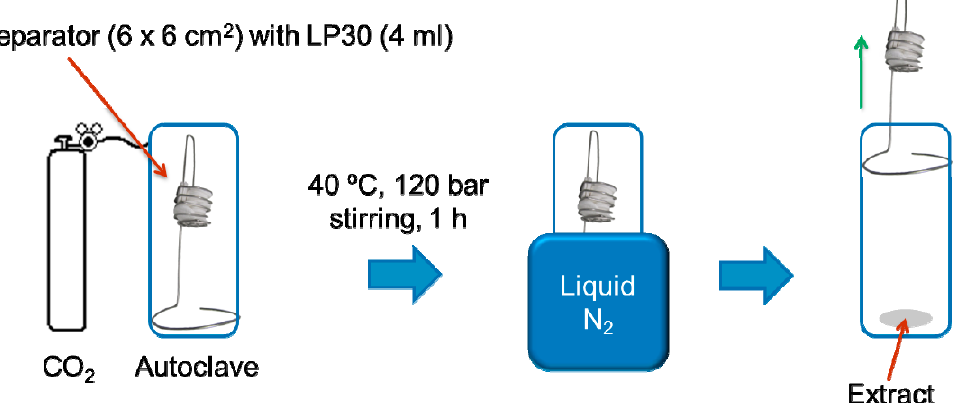
Figure 6. Schematic setup of the applied extraction procedure by Grützke et al. It was reproduced from reference [19] with permission from Elsevier, 2014.